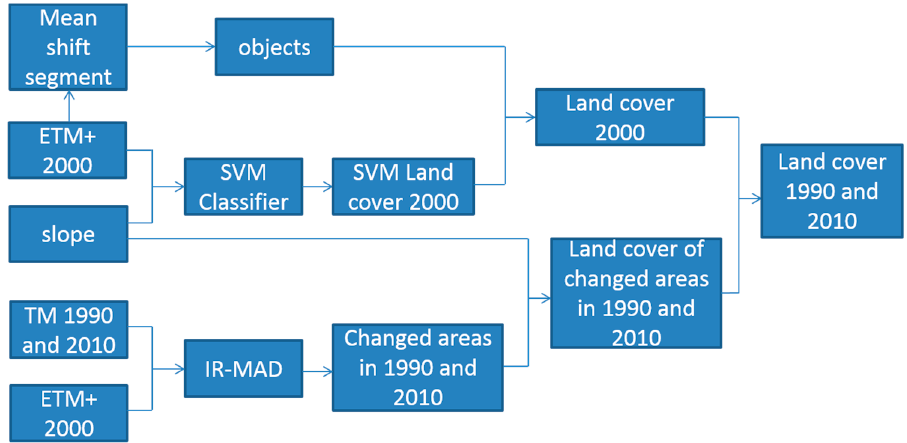
Figure 2. Flow diagram of the land cover and land use change (LCLUC) classification. IR-MAD, iteratively re-weighted multivariate alteration detection.